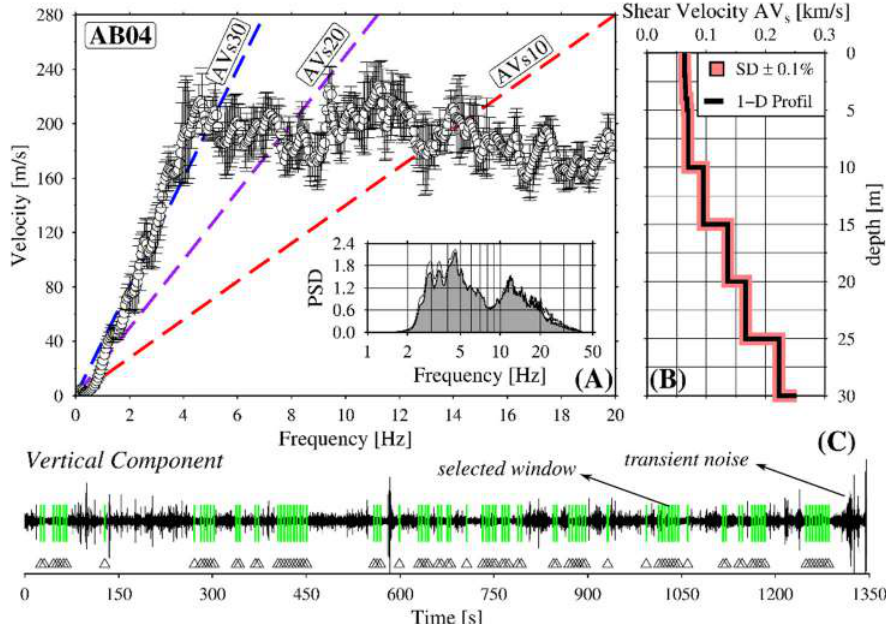
Fig. 3: (a) Dispersion curve of microtremors recorded at site AB09 describing the relationship between frequency and velocity following the linear trend (AVs 1‐10 (blue), AVs 11‐20 (purple), and AVs 21‐30 (red)). The AVs trend at a specific depth (10, 20, and 30 m) was set based on the average value in the thick layer at a shallow depth. (b) AVs was converted with Eq. 3 to obtain Vs as the representative value for a specific depth. The graph shows a three‐ layer graph formed by Vs over depths of 10, 20, and 30 m. (c) Example of waveform recording in the vertical component at AB09 and the segmentation window (green triangle)